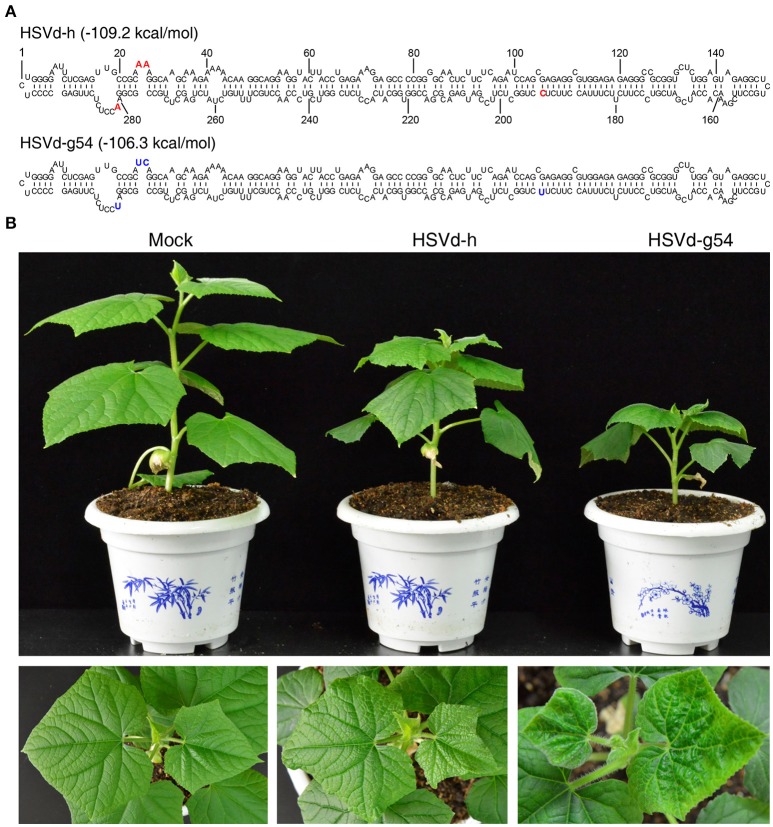
Secondary structures of hop stunt viroid variants HSVd-h and HSVd-g54, and disease symptoms of cucumber plants infected with HSVd-h and HSVd-g54. (A) The positions of nucleotides in HSVd-g54 that differ from HSVd-h are shown in bold type. (B) Differences in plant height and leaf morphology among cucumber plants inoculated with sodium phosphate buffer (mock), HSVd-h, and HSVd-g54. Note that the leaves of plants infected with HSVd-g54 were more wrinkled than those infected with HSVd-h.